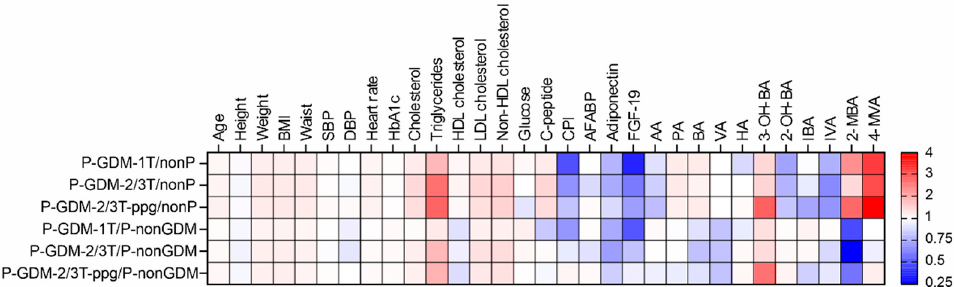
Figure 4. Heat map of fold-change values between the groups of women with GDM and controls.